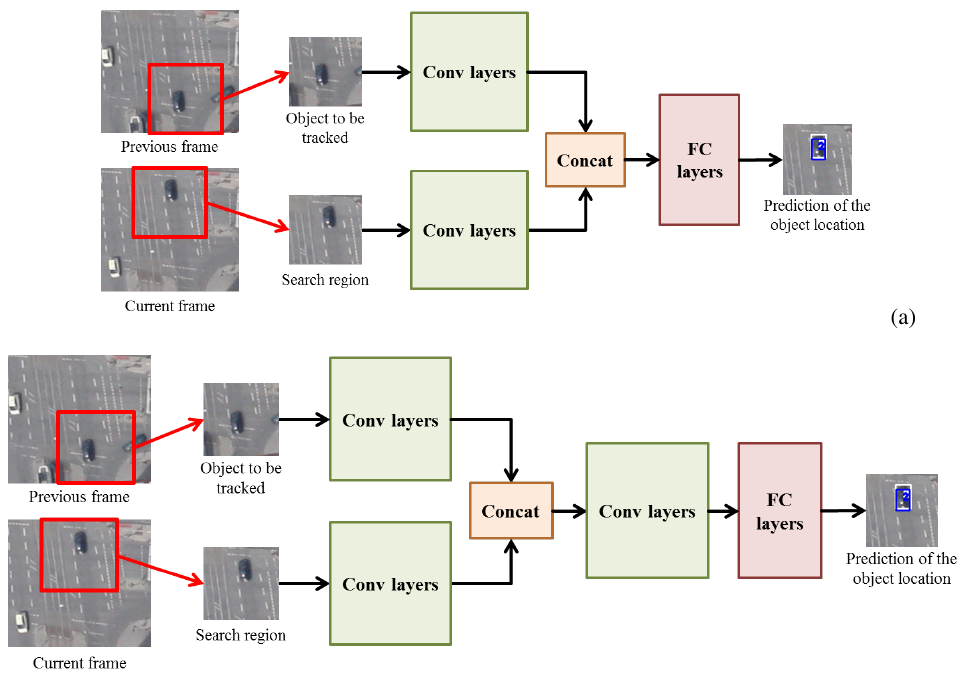
Figure 2. Overview of (a) GOTURN and (b) our proposed modification to